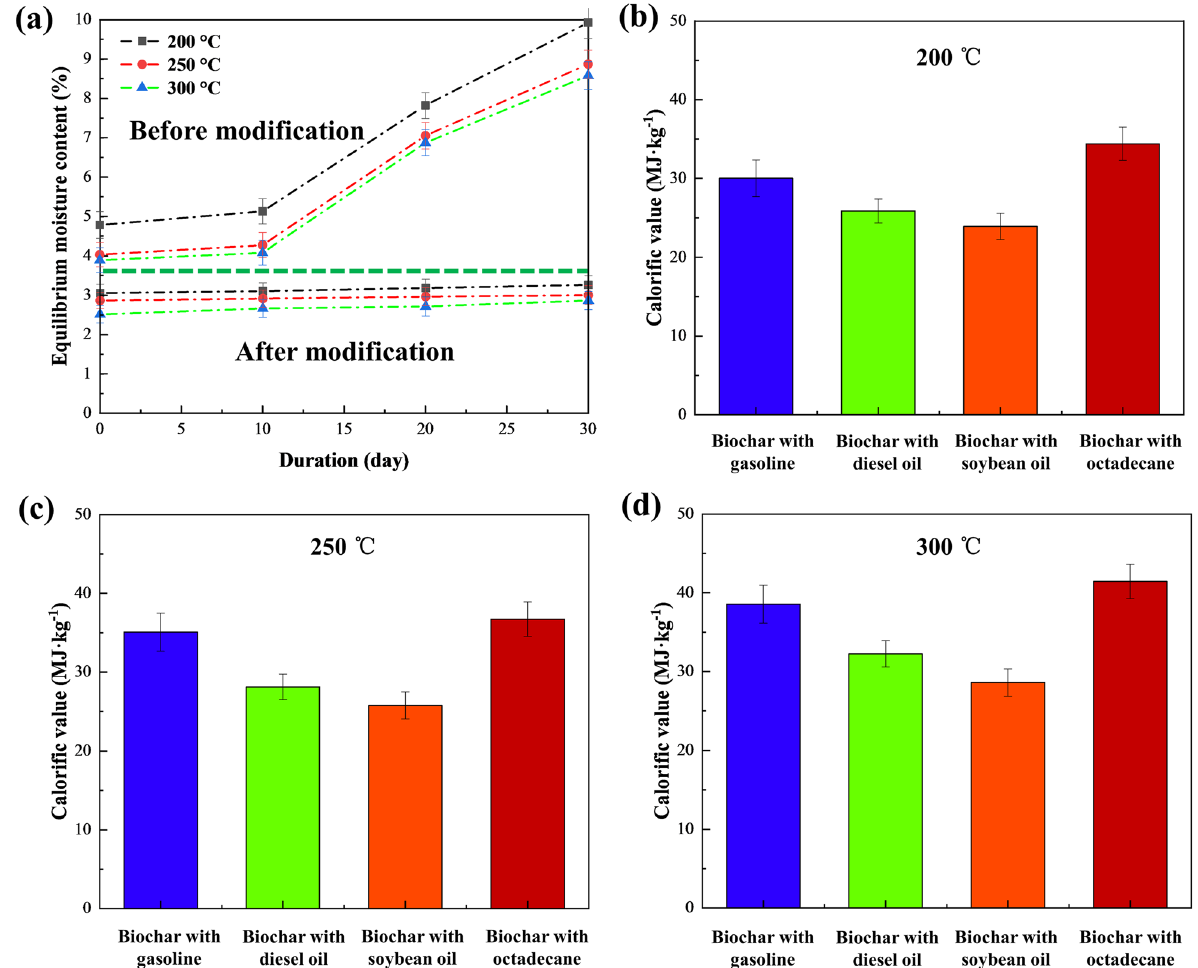
Fig. 5 a Equilibrium moisture content of microalgal biochar, and b–d calorific value of microalgal oilchar